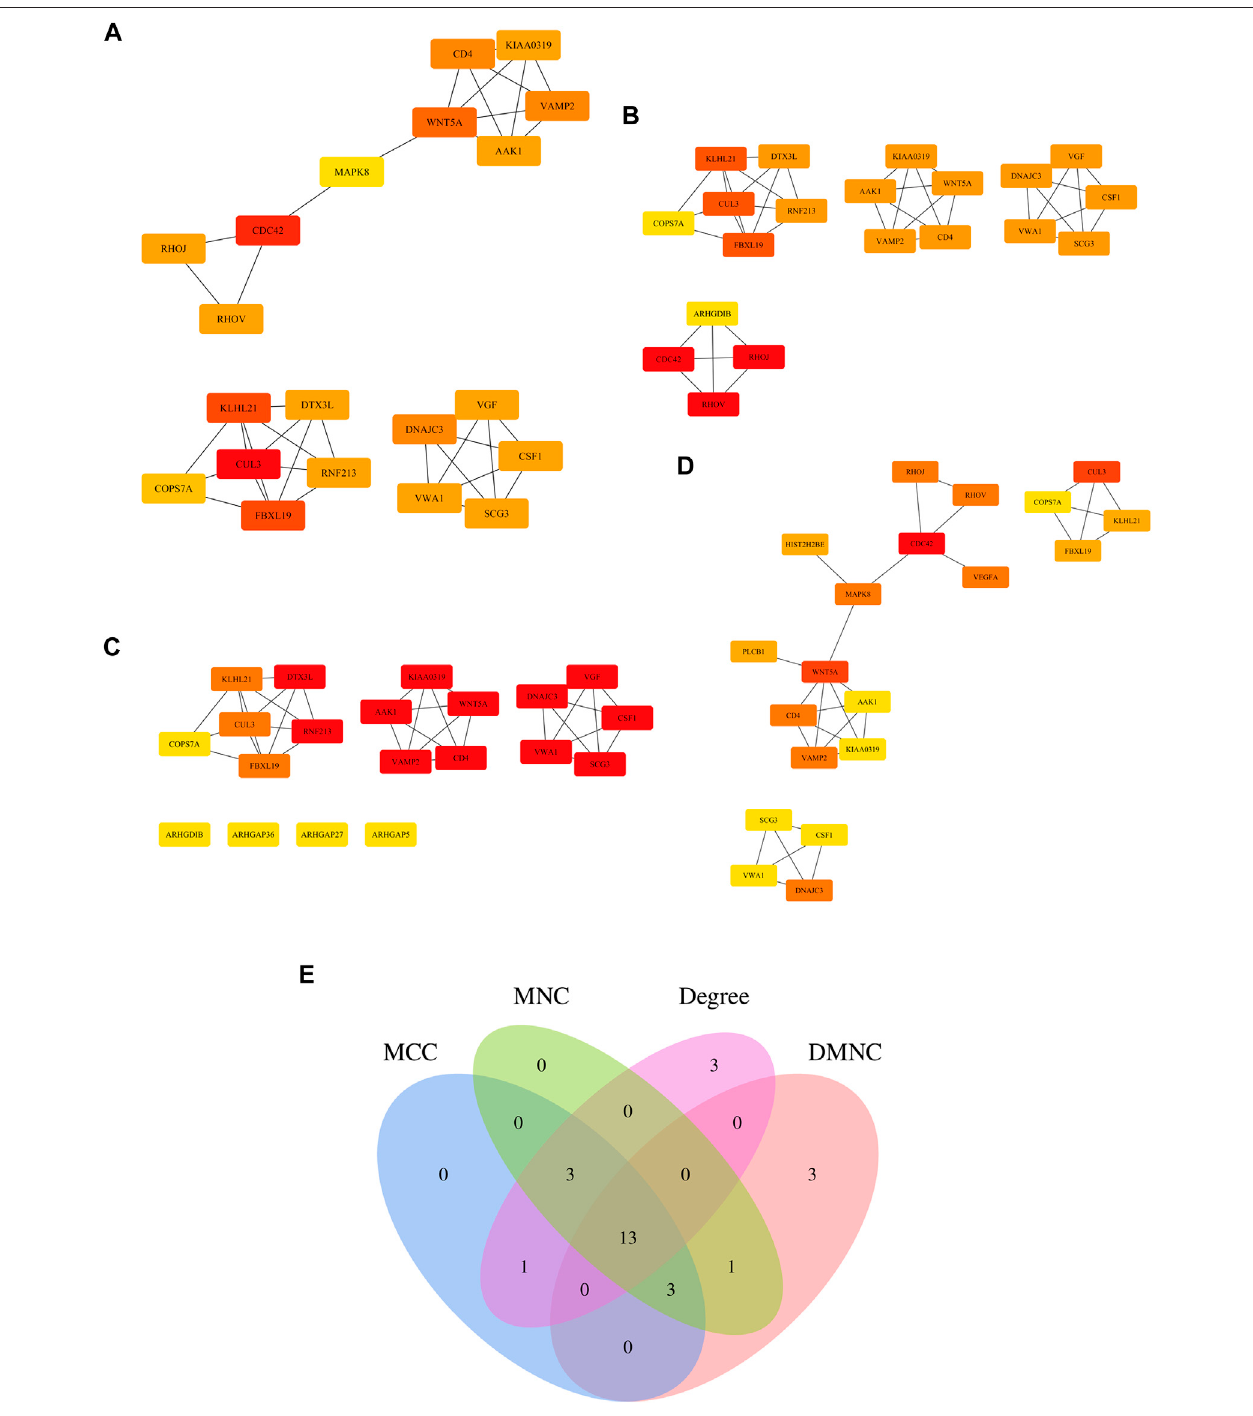
FIGURE5| Determinationofthecentralgenesofthe94coretargets. (A – D) Fourdifferentmetricswereused,suchasMaximalCliqueCentrality(MCC) (A) ,Density ofMaximumNeighborhoodComponent(DMNC) (B) ,MaximumNeighborhoodComponent(MNC) (C) ,andDEGREE (D) toanalyzecentralgenesofthe94coretargets. (E) Venn diagram showing 13 overlapping central genes from these four metrics.